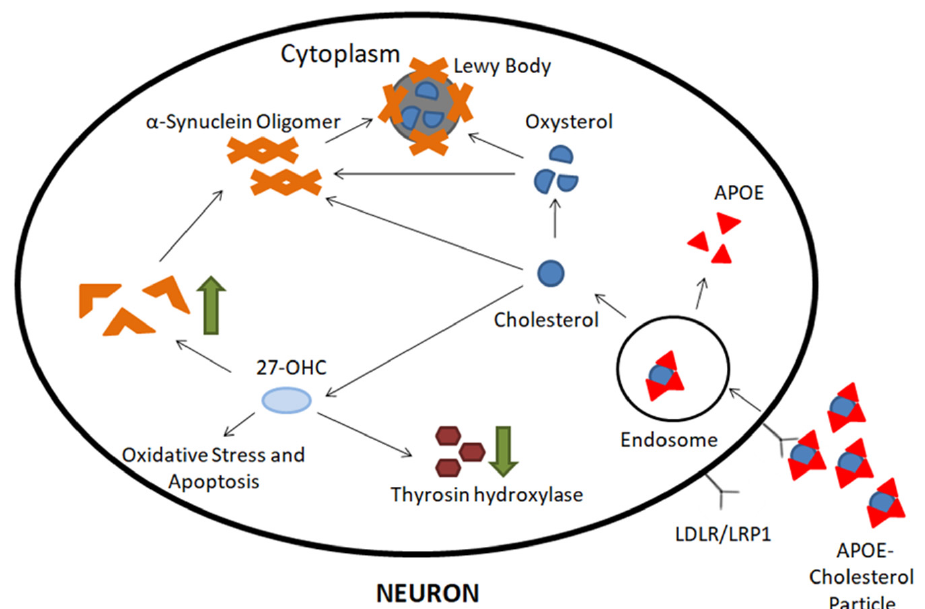
Figure 3. Cholesterol metabolism in Parkinson’s disease. After endocytosis of apolipoprotein E (APOE)-cholesterol particles, cholesterol is metabolized to 27-hydroxylcholesterol (27-OHC) and other oxysterols. Furthermore, 27-OHC can increase α -synuclein synthesis, downregulate tyrosine hydroxylase (TH) activity, and cause oxidative stress and apoptosis. In addition, excessive cholesterol and oxysterol can promote α -synuclein aggregation, and aggregated α -synuclein will eventually form Lewy bodies (LBs).